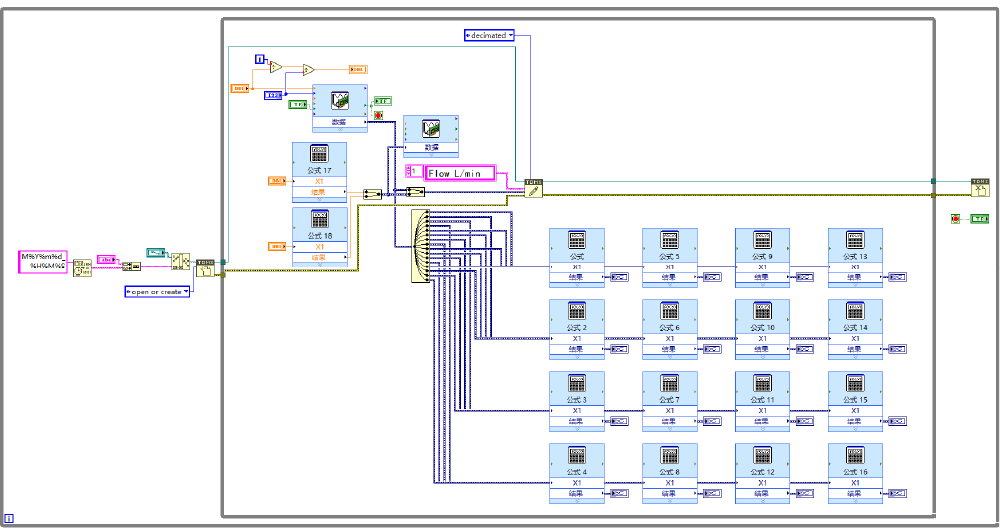
Figure 11. Data acquisition graphical program.